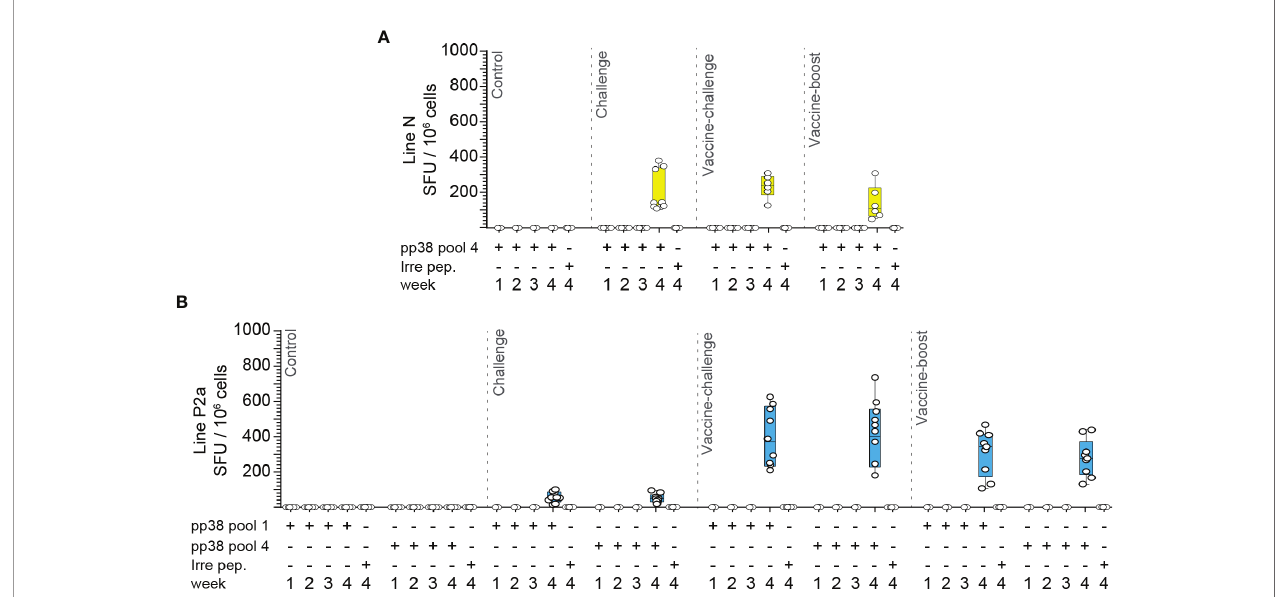
FIGURE 8 | MDV infection of naïve line N chickens induces higher frequencies of IFN-gamma producing pp38 -speci fi c T cells compared to that in line P2a chickens. Mononuclear cells isolated from different experimental groups (Control, Infected, vaccine-challenge, and vaccine-boost) were cultured in the presence of rchIL-2 and the pp38 peptide pools 1, 4 or an irrelevant peptide for 9 – 10 days. Antigen-speci fi c IFN-gamma producing T cells were analyzed using cultured chIFN-gamma ELISPOT assay at days 9 – 10 post culture. The frequency of antigen speci fi c IFN-gamma producing T cells (SFU/10 6 cells) are presented for weeks 1 – 4 post the last inoculation from the (A) line N and (B) line P2a chicken lines. All ELISPOT assays were performed in triplicates and the results are representative of at least 6 chickens within each experimental group from either the line N or line P2a chickens. The results are presented as SFU per 10 6 cells and shown as mean ±